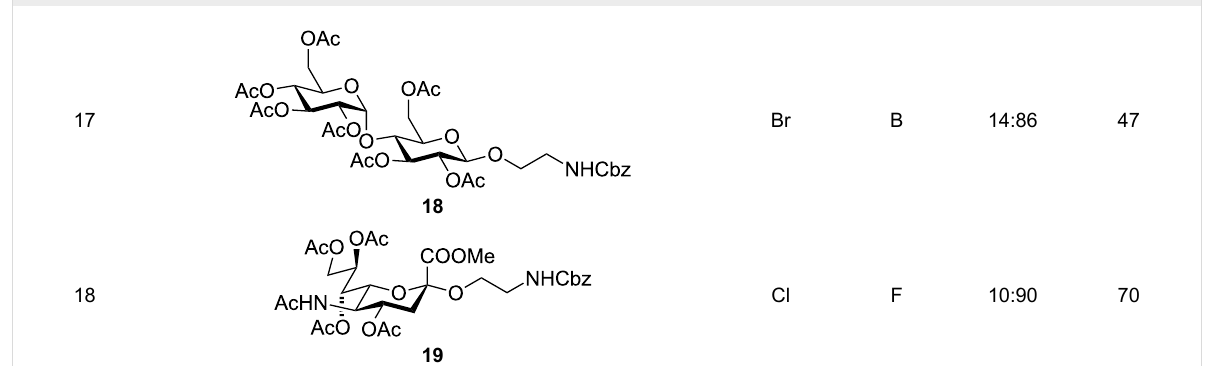
Table 1: Results of glycosylation reactions as shown in Scheme 1. (continued)